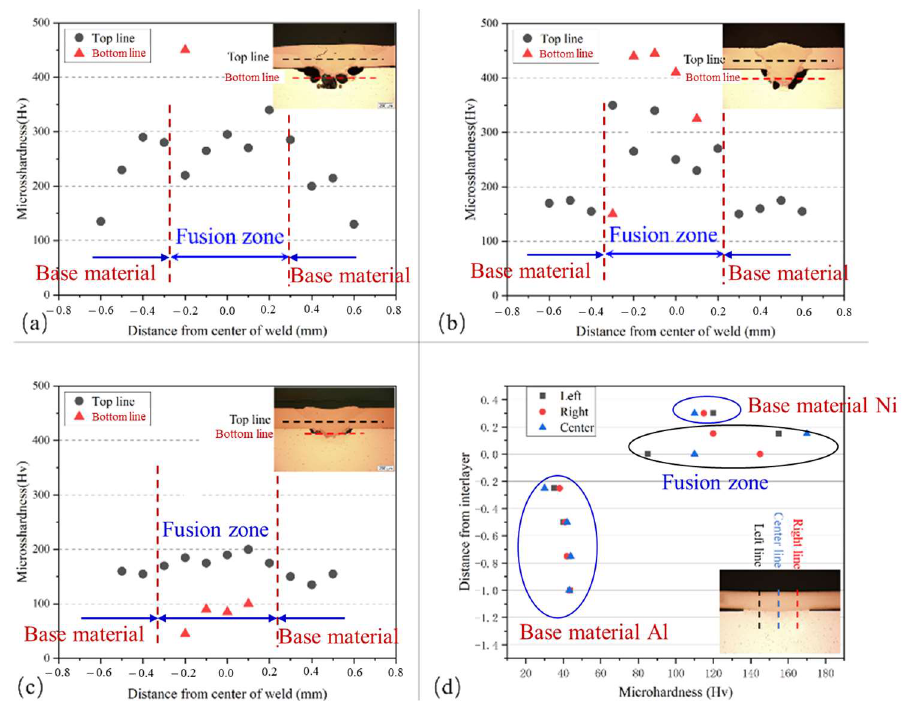
Figure 9. The hardness distribution of laser weld: ( a ) PW (150 W), ( b ) CW (1800 W, focal point position 0), ( c ) PW (120 W) and ( d ) CW (1800 W, focal point position +5).